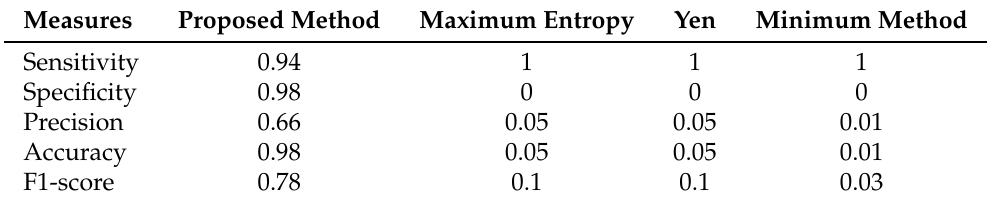
Table 4. Comparison of the performance factors of proposed method with other selected method—data set